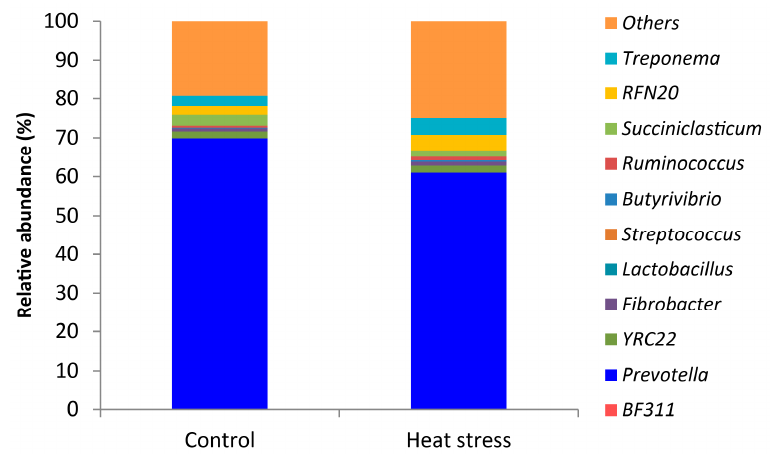
Figure 4. The relative abundant (%) of genera in the rumen of dairy cows with or without heat stress.